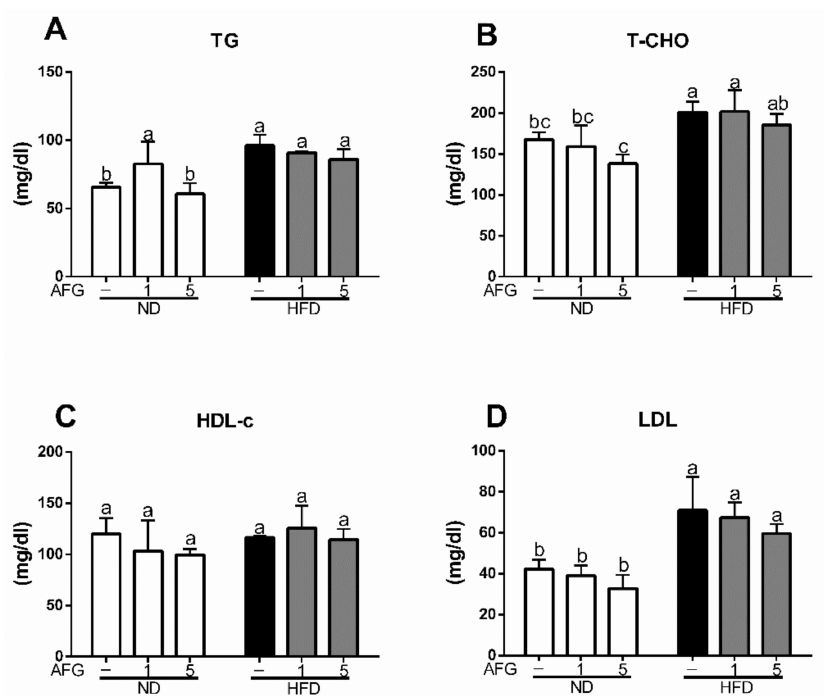
Figure 2. E ff ect of allicin-free garlic on lipid metabolism. ( A – D ) Influence of allicin-free garlic supplementation on serum level of total triacylglycerol (TG), total cholesterol (T-Cho), high-density lipoprotein cholesterol (HDL-c) and low-density lipoproteins (LDL). The data represent the mean ± SD of four mice for each group. Columns with di ff erent letters significantly di ff er ( p <